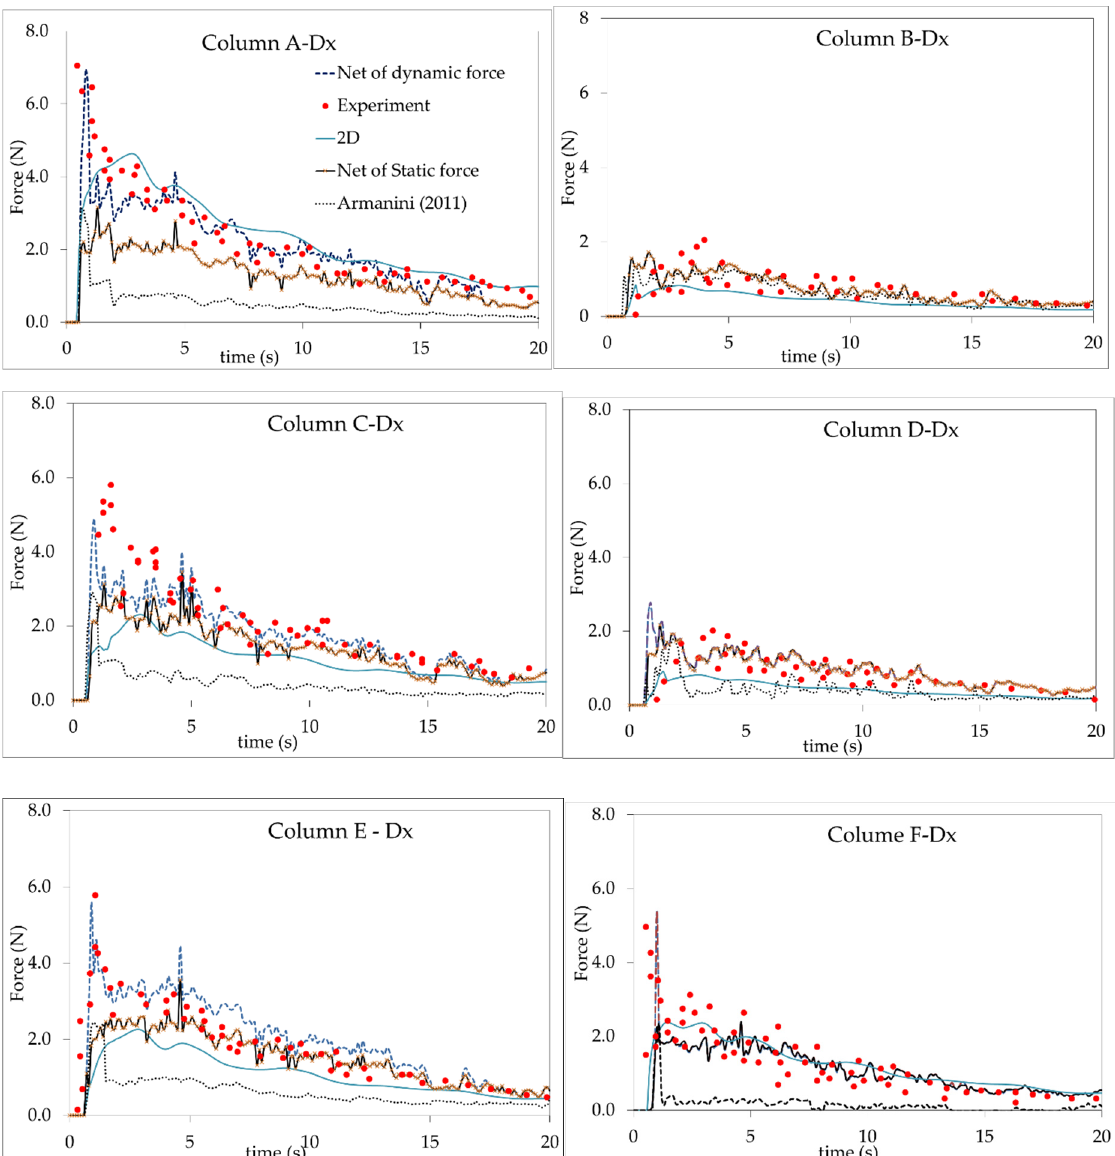
Figure 9. Force in the flow direction exerted on 6 buildings.